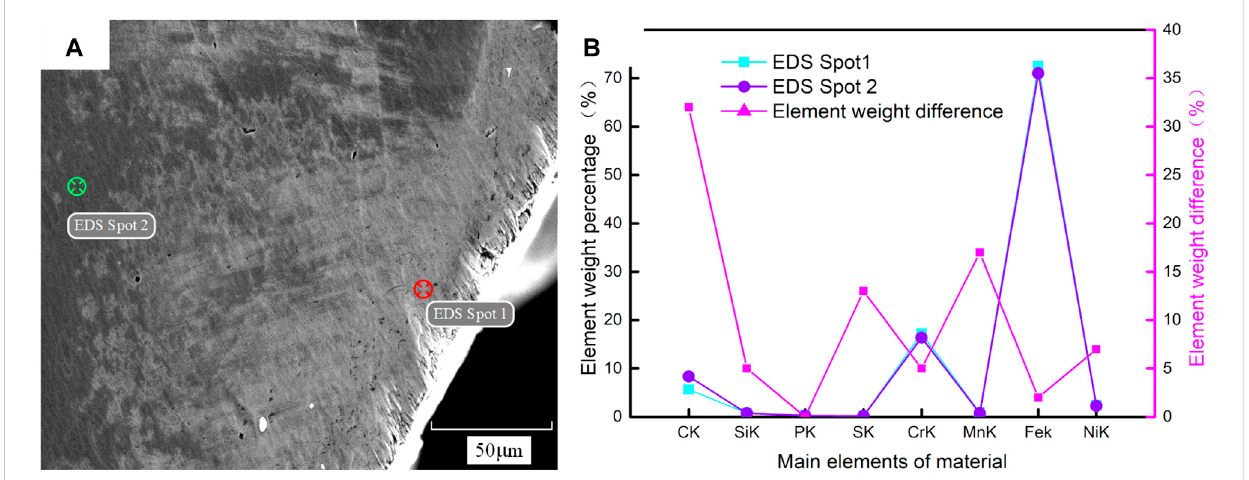
FIGURE 5 Element distribution on the ground surface. (A) Schematic diagram of detection points. (B) Element content